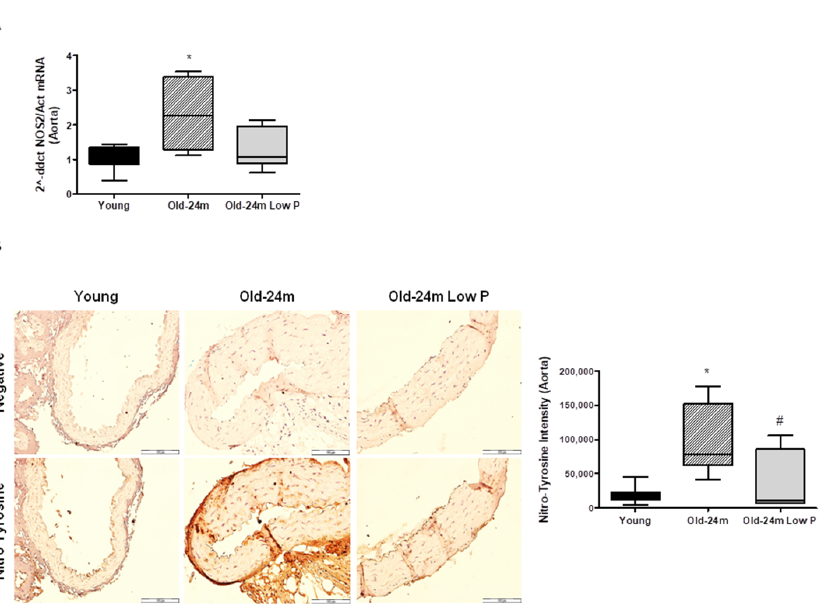
Figure 4. Hyperphosphatemia induces NOS2 expression and nitrosative damage in aorta from old mice. Male C57Bl6 mice from 5 month old (Young, closed bars), 24 month old fed with normal diet (Old-24 m, striped bars) and 24 month old mice fed with a low phosphate diet for the last 3 months (Old-24 m Low P, grey bars) were used. ( A ) NOS2 expression was evaluated by real time PCR in aortic tissue. ( B ) Nitrotyrosine expression is shown in the aorta slices from mice (40 × ) with the graph of densitometric analysis on the right panel. Scale bar, 100 µm. ( C ) Values are the mean ± SEM of 6 mice per group, * p < 0.05 vs. young, # p < 0.05 vs. Old-24 m.